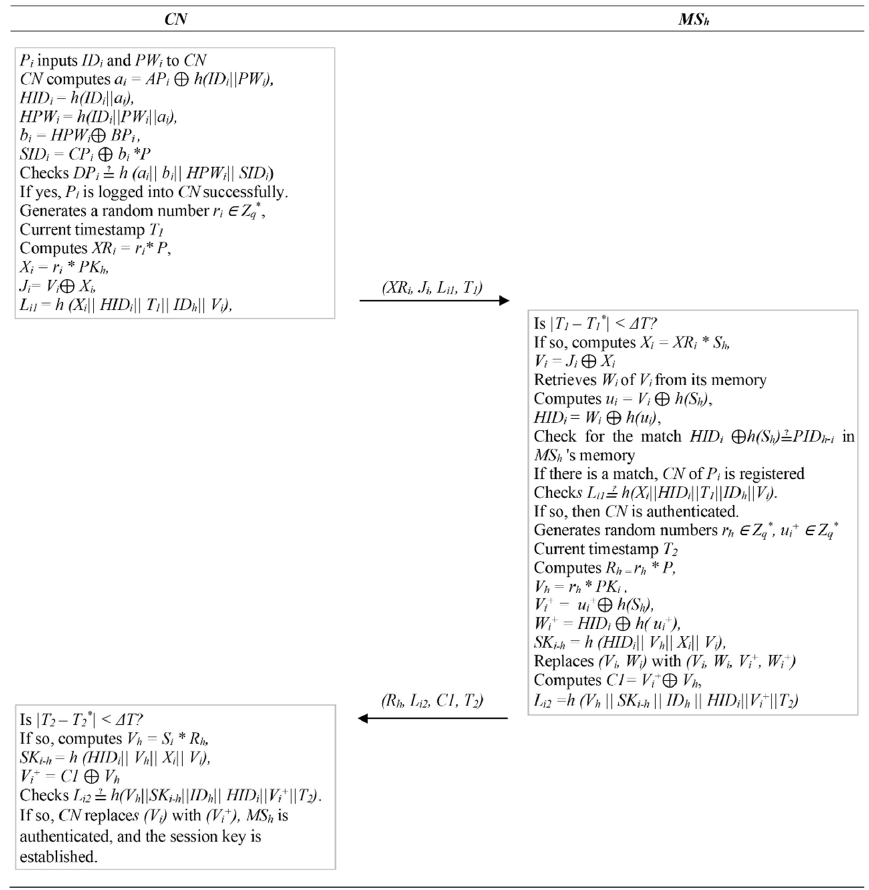
Figure 4. Authentication P-I.